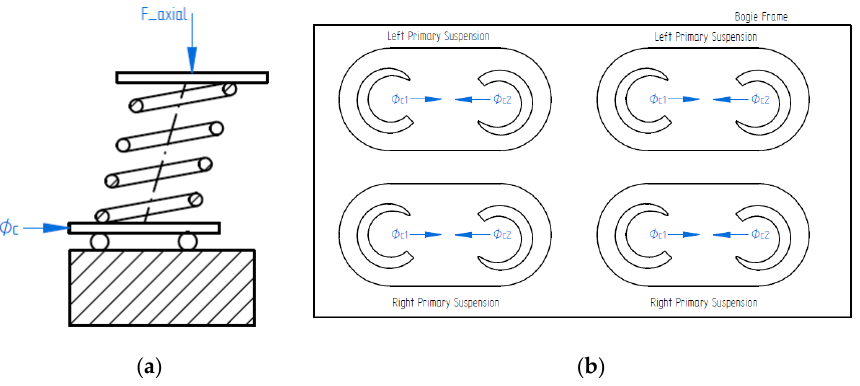
Figure 2. “Effort de chasse” or transverse flexibility: ( a ) schematic of the test device; ( b ) mounting on a spring bogie compensating the “effort de chasse”.